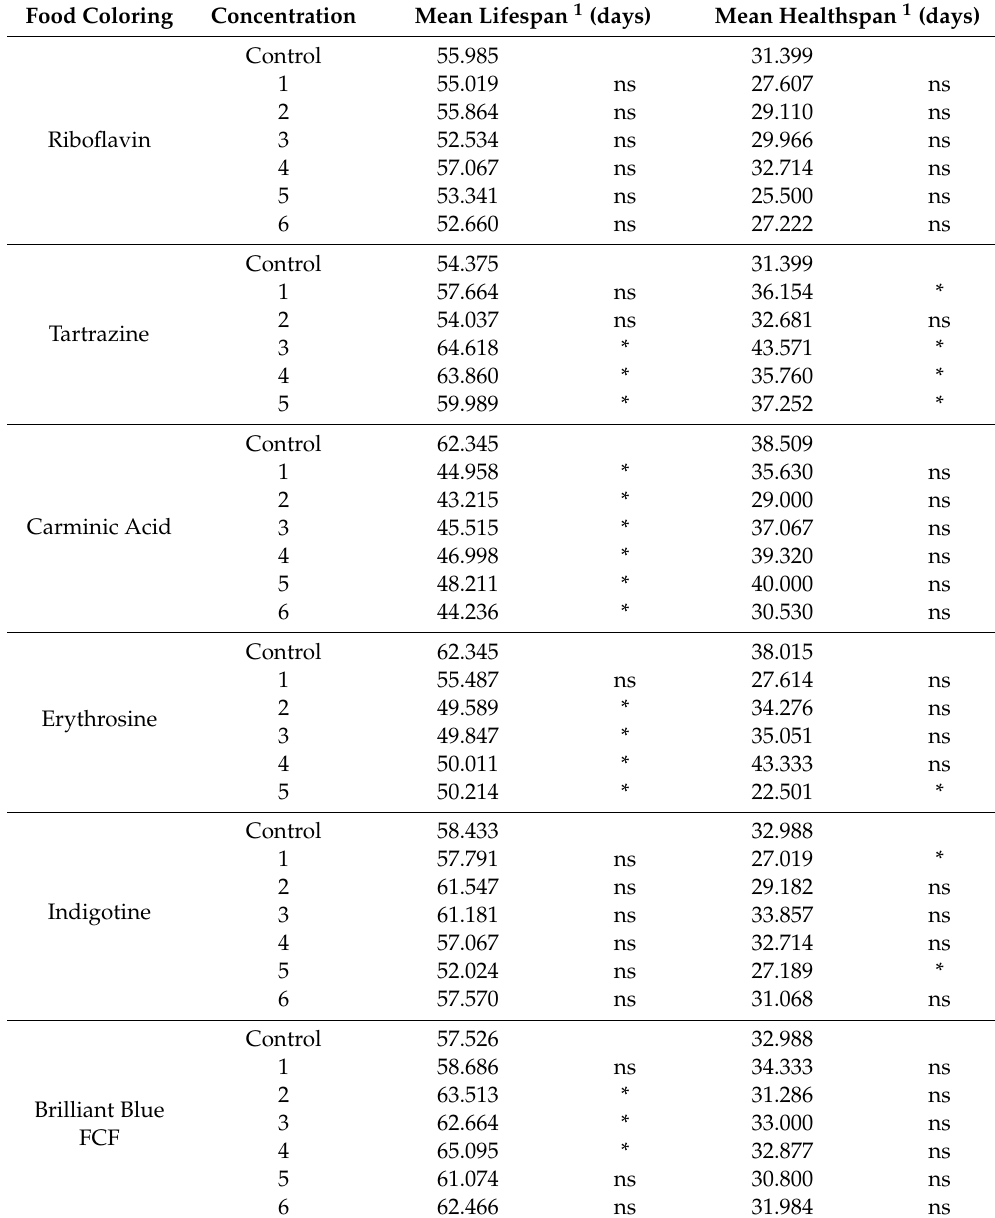
Table 3. Mean and significances of lifespan and healthspan